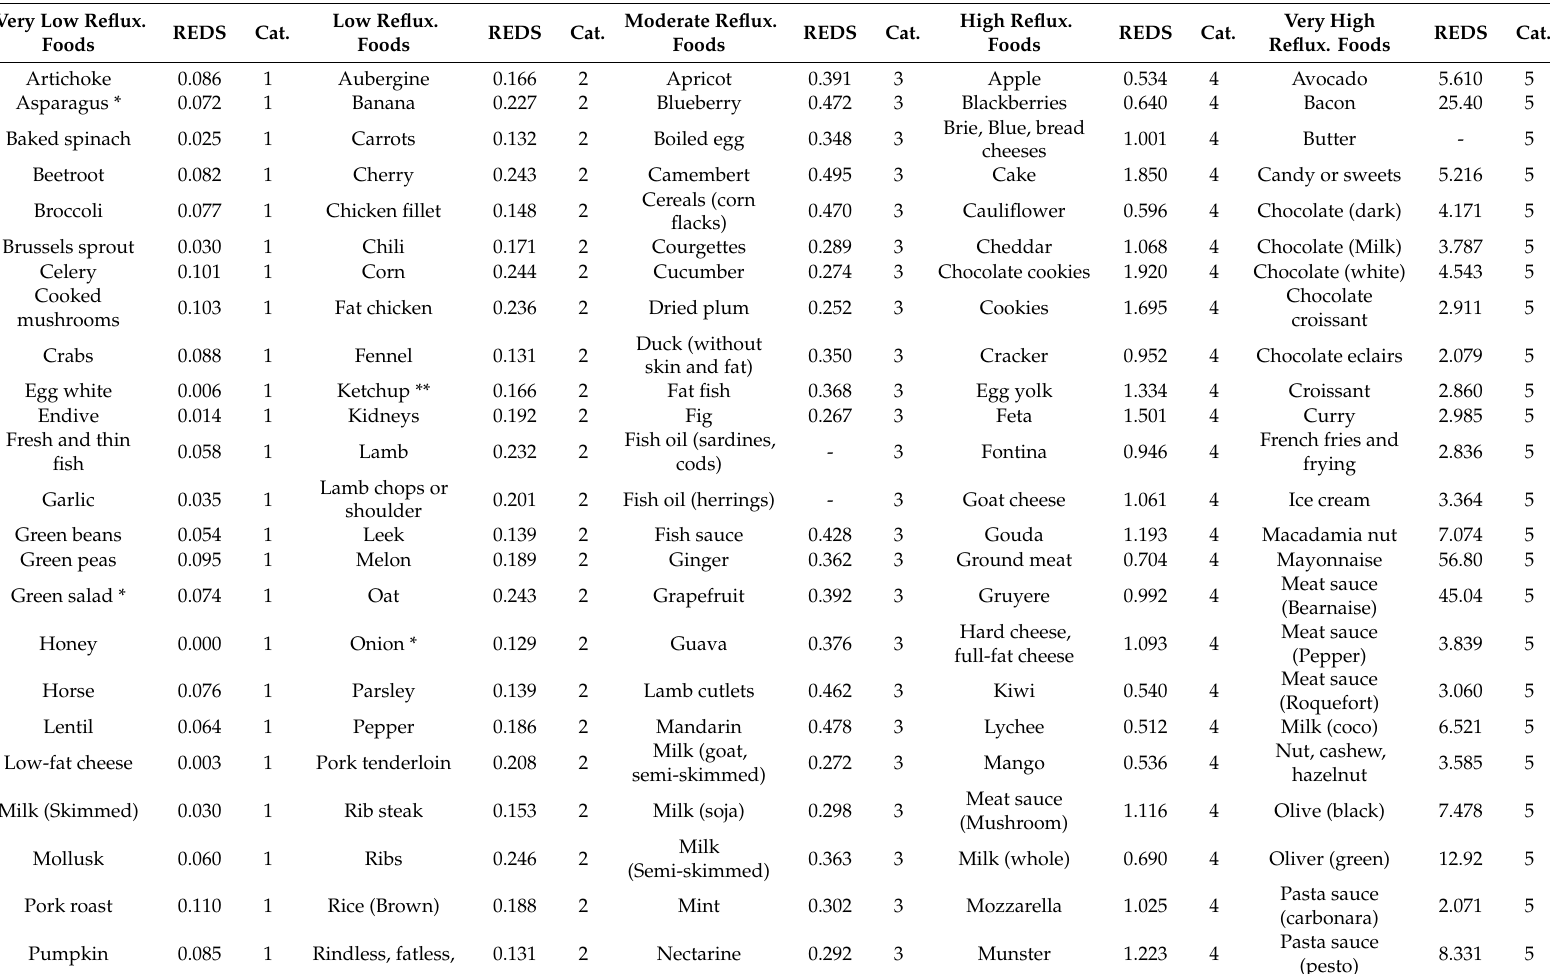
Table 4. The Refluxogenic Diet Score of foods and their Refluxogenic